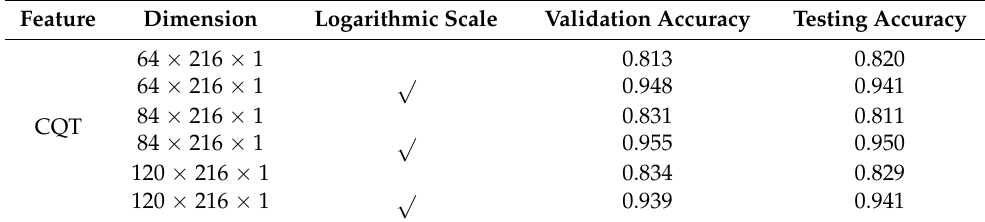
Table 5. Accuracy comparison for CQT feature.